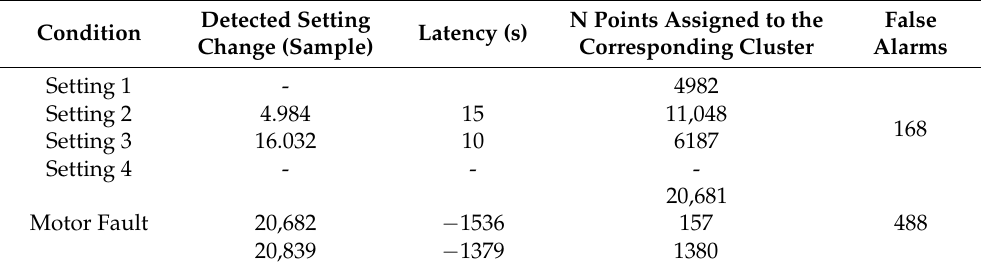
Figure 8. Results of the AAD + ADP algorithm (electric motor) for ( a ) operating condition recognition, and ( b ) fault detection. Table 4. Performances of clustering-based with pretraining approach (electric motor).